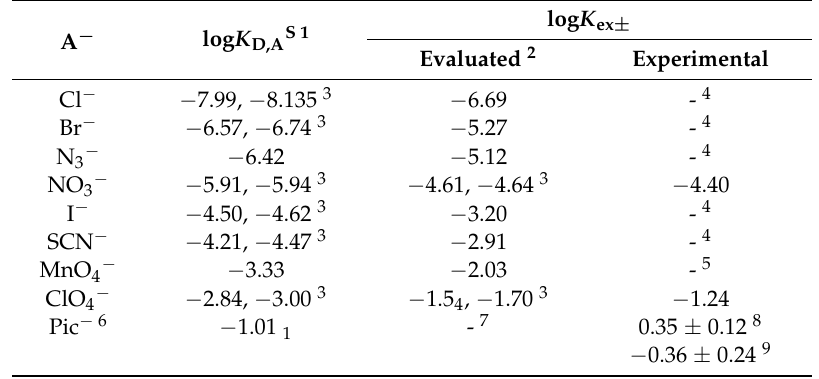
Table 3. Log K ex ± values evaluated from the log K D,AS and log K Ag/AgLS values at B18C6 (= L), DCE, and 298